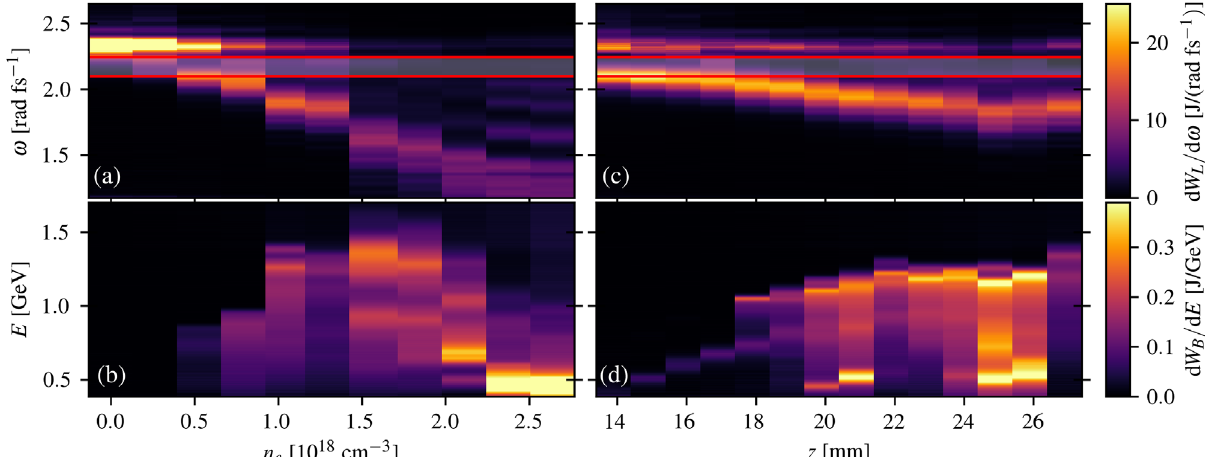
FIG. 1. Laser and electron spectrum at the exit of the 27-mm gas cell as functions of electron density (a) and (b) and as functions of ¼ 1 . 25 (cid:1) 0 . 06 × 10 18 cm − 3 (c) and (d). The red-bordered region in the laser spectra plots indicates the gap accelerator stage length for n e between the measurement ranges of the two spectrometers, which was filled by interpolation. Each column of each image shows the average from three to five shots at the same